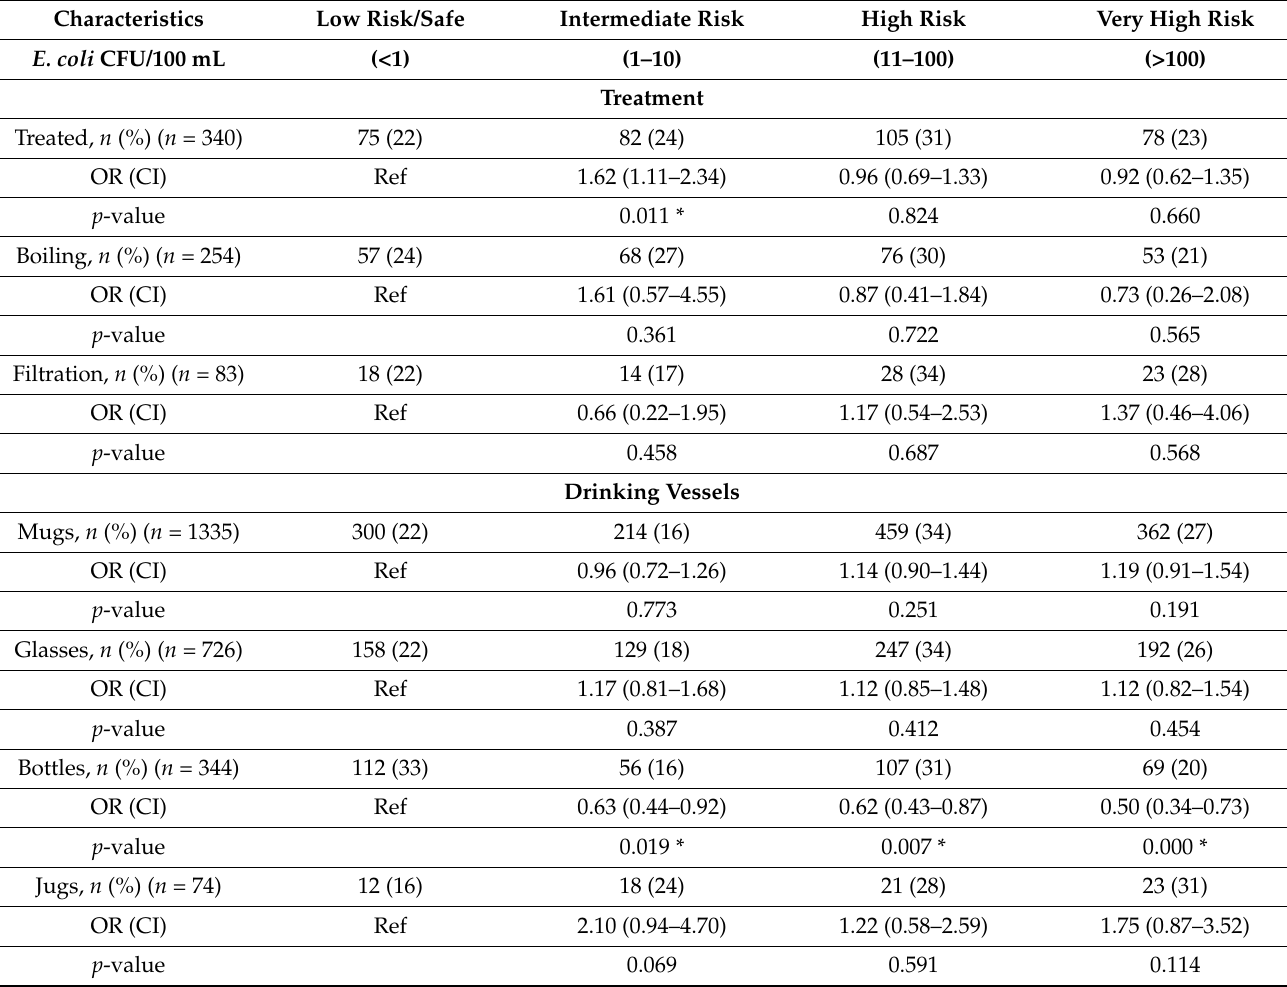
Table 4. Results of logistic regression analysis for the odds of belonging to one of the WHO drinking water risk categories (using the low risk group as the